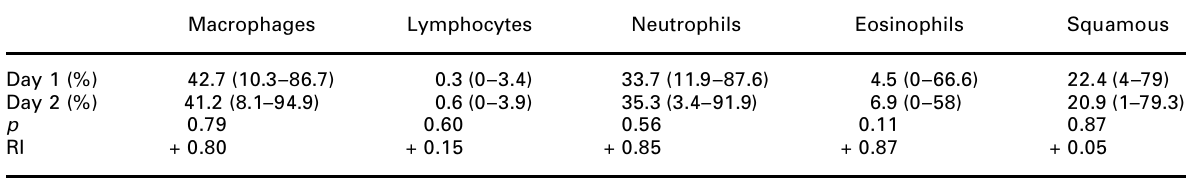
Table 2. Reproducibility of inflammatory cell percentages in induced sputum of asthmatic subjects